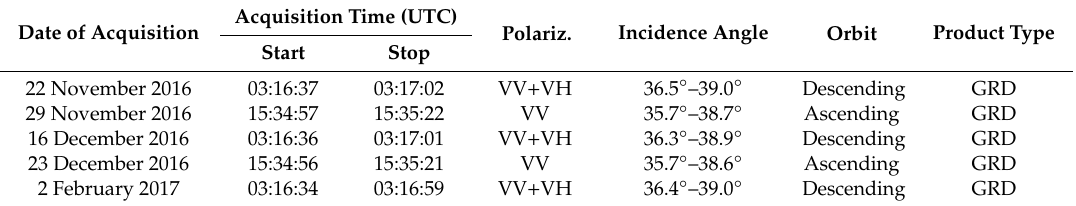
Table 1. Acquisition time, polarization, and incidence angle and orbit of Sentinel-1 Synthetic Aperture Radar (SAR) Interferometric Wide-Swath (IWS) Mode in the study area.